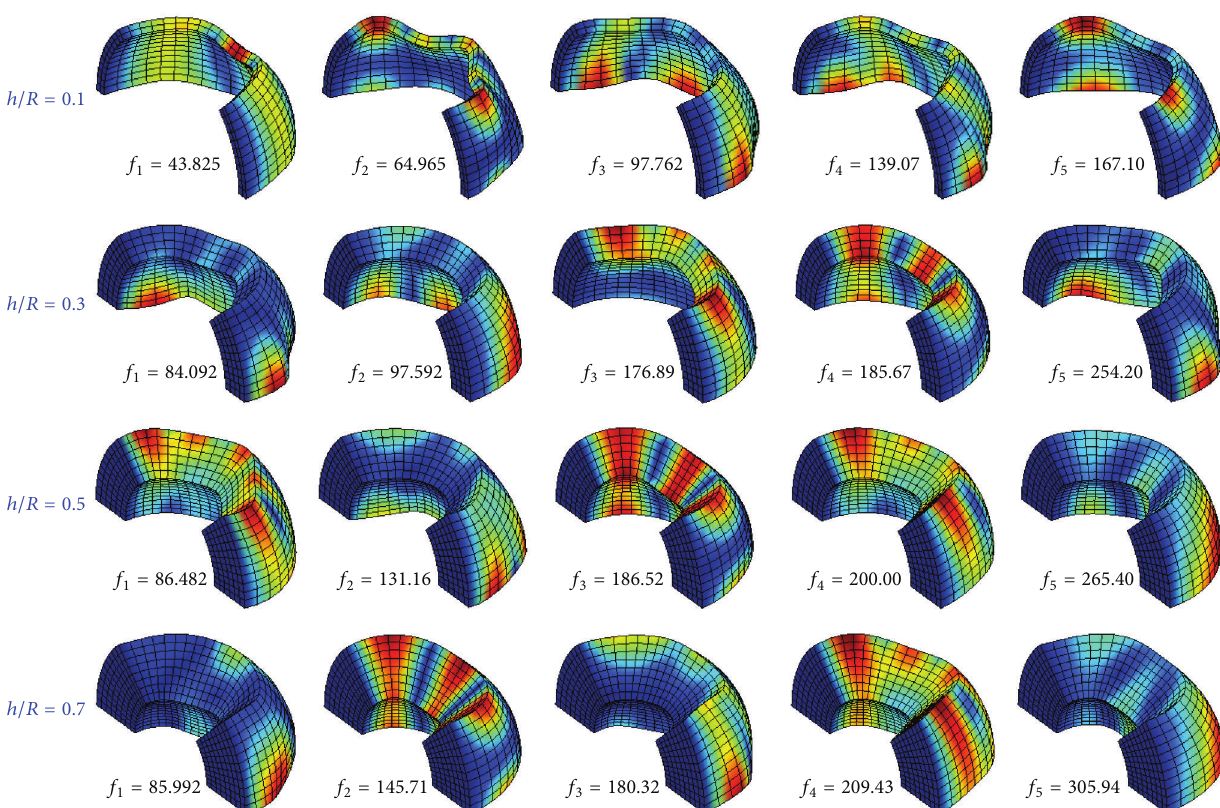
Figure 8: Mode shapes of an orthotropic spherical shell with FCFC boundary conditions and various thickness-radius ratios.